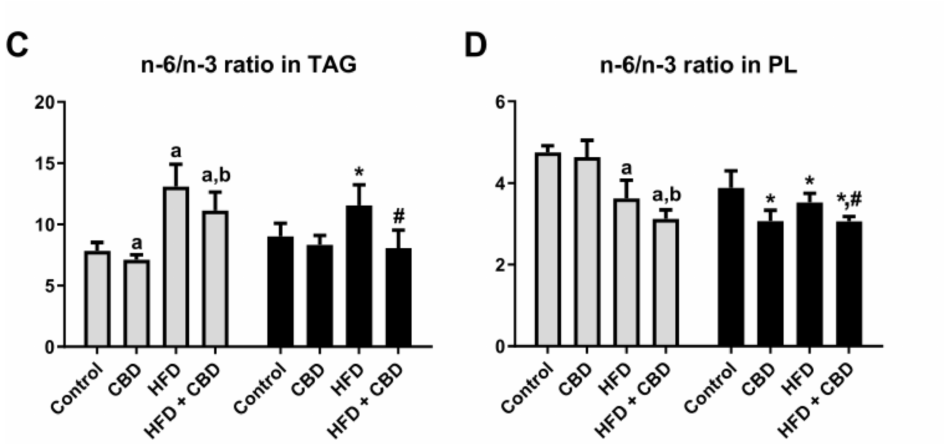
Figure 1. Intramuscular n-6/n-3 PUFA ratio in the ( A ) free fatty acid (FFA), ( B ) diacylglycerol (DAG), ( C ) triacylglycerol (TAG) and ( D ) phospholipid (PL) fractions in the white and red gastrocnemius muscles in the control (standard diet) and high-fat diet (HFD) groups after two-week cannabidiol (CBD) treatment. The data are expressed as mean values ± SD, n = 10 in each group. a p < 0.05 indi- cates a significant difference: the control group vs. the examined group in the white gastrocnemius muscle; b p < 0.05 indicates a significant difference: HFD vs. HFD + CBD in the white gastrocnemius muscle. * p < 0.05 indicates a significant difference: the control group vs. the examined group in the red gastrocnemius muscle; # p < 0.05 indicates a significant difference: HFD vs. HFD + CBD in the red gastrocnemius